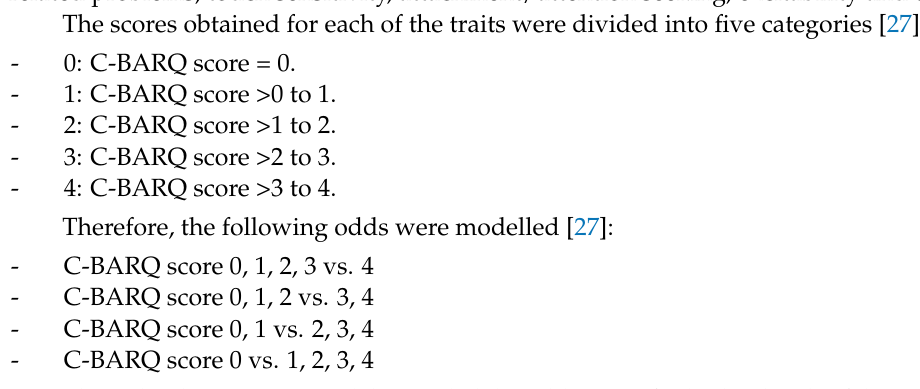
Table 3. Mean (with 95% confidence interval) scores obtained for general population (GP) dogs and Can de Palleiro breed (CP) for the different traits considered in the Canine Behavioural Assessment and Research Questionnaire.